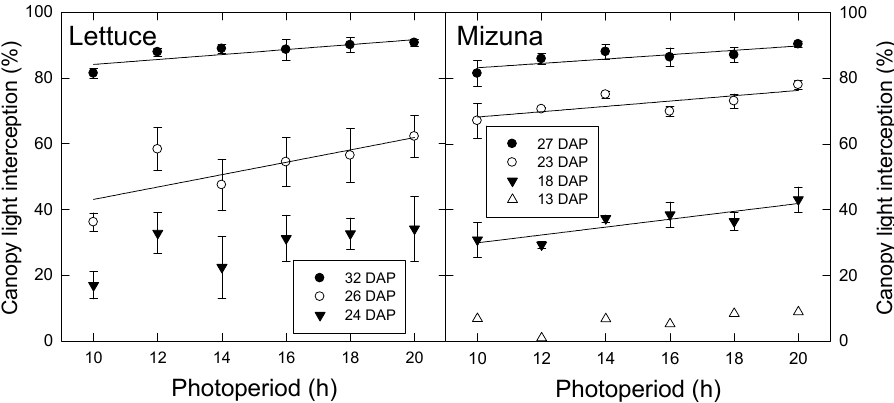
Figure1. Canopylightinterceptionoflettuce( left )andmizuna( right )grownwithvaryingphotoperiods Figure 1. Canopy light interception of lettuce ( left ) and mizuna ( right ) grown with varying with the same daily light integral of 16 mol · m − 2 · d − 1 . Data were collected during the first experiment photoperiods with the same daily light integral of 16 mol·m − 2 ·d − 1 . Data were collected during the first on di ff erent days after planting (DAP). Lines indicate significant linear e ff ects of photoperiod ( p < experiment on different days after planting (DAP). Lines indicate significant linear effects of photoperiod ( p < 0.05).